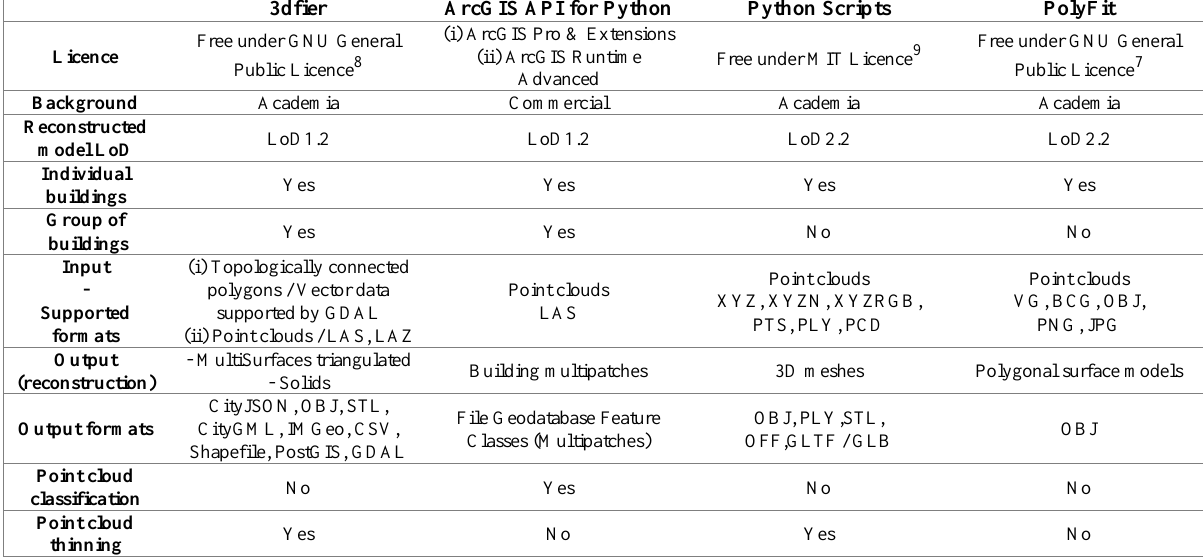
Table 5. Comparison of the key points for each software which help determine which one is worth for further testing.